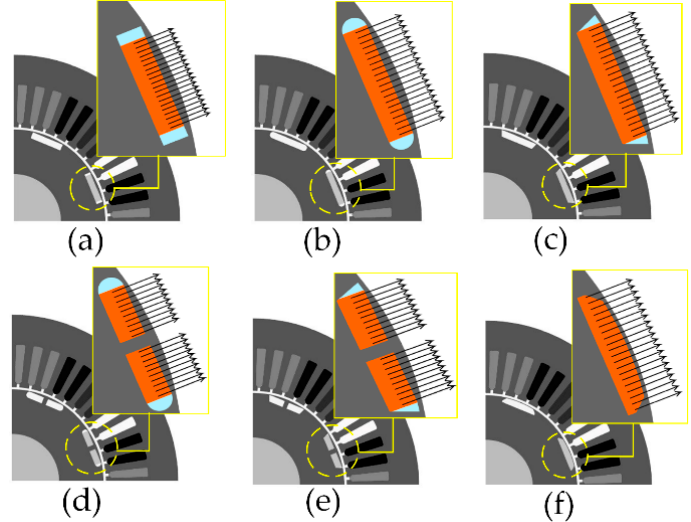
Figure 2. Qualitative layout of the considered rotor magnet arrangements: ( a ) R-ROW, ( b ) R-SOW, ( c ) R-IOW, ( d ) RCL-SOW, ( e ) RCL-IOW, and ( f ) H-NOW. Each subplot represents two of the eight poles of the rotor.